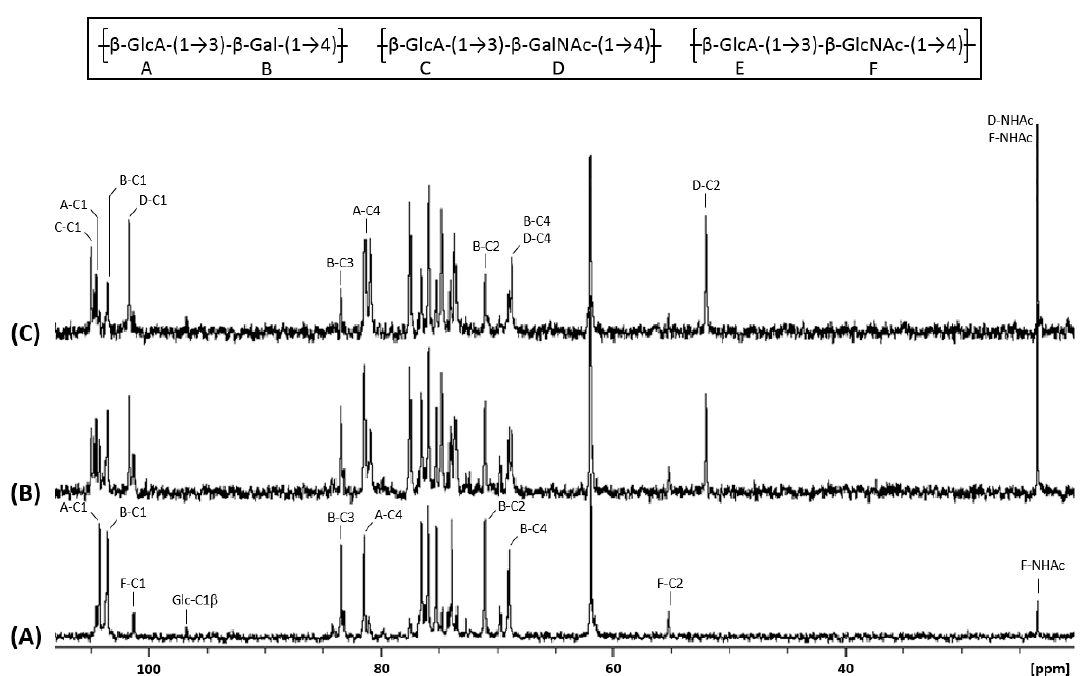
Figure 4. 13 C NMR spectra of chondbiuronan ( A ) and chondroitin obtained using 0.5% ( B ) and 2% ( C ) arabinose induction. Inset: chemical structure of the polysaccharides.